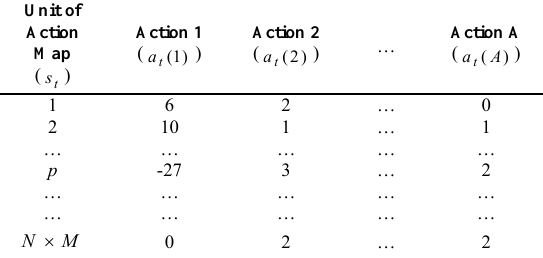
Table 1. The value of units Q t ( s t , a t ) on Action